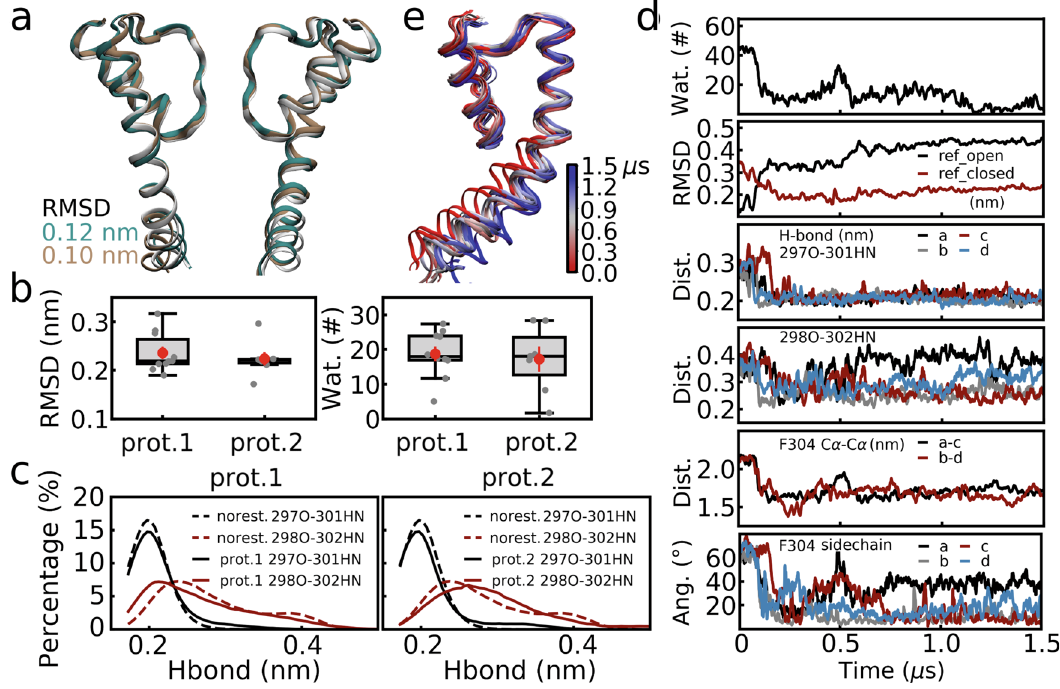
Fig. 5 | Conformational transition from the open to closed state resulted in cavitydehydration.a Comparisonoftheconformationoftheclosedstatechannel obtained from non-equilibrium (protocol 1: cyan; protocol 2: brown) and equili- brium simulations (white). The average structures of all simulation replicas using dummy atoms are aligned to that of the equilibrium simulations. b Boxplot of RMSD values (left) and the numbers of waters in the cavity for each simulation replica. Similar to Fig. 4, the RMSD of the average structure for each non- equilibrium simulation replica was calculated relative to that for the equilibrium simulations. n =10 and n =7 independent simulation replicas were conducted for protocol 1 and protocol 2. The center line, box limits, and whiskers represent the median, upper and lower quartiles, and 1.5×interquartile range. Data points are